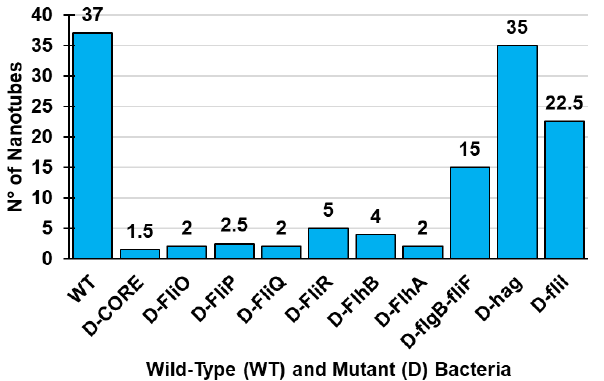
Figure 4. Average number of BNTs displayed per 50 cells by the indicated mutant strains following XHR-SEM analysis.